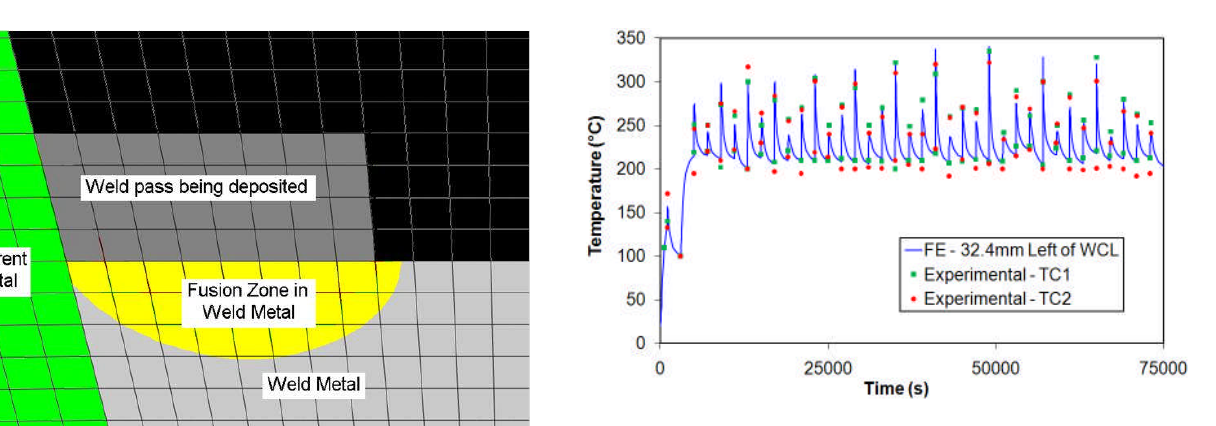
Figure 10. Temperature measurements by TC1 and TC2 and FE temperature history. Figure 8. Fusion zone when heat flux is applied only to weld elements.